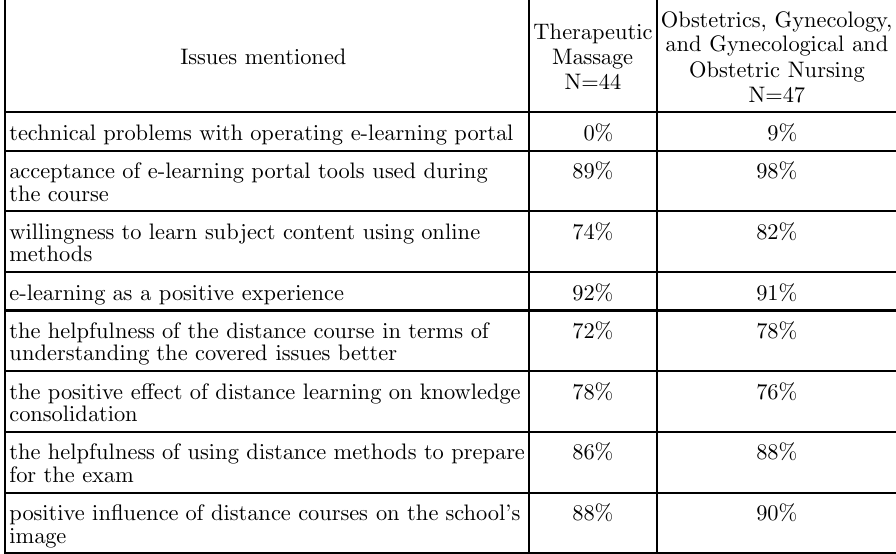
Table 2. Opinion of students of the Medical University of